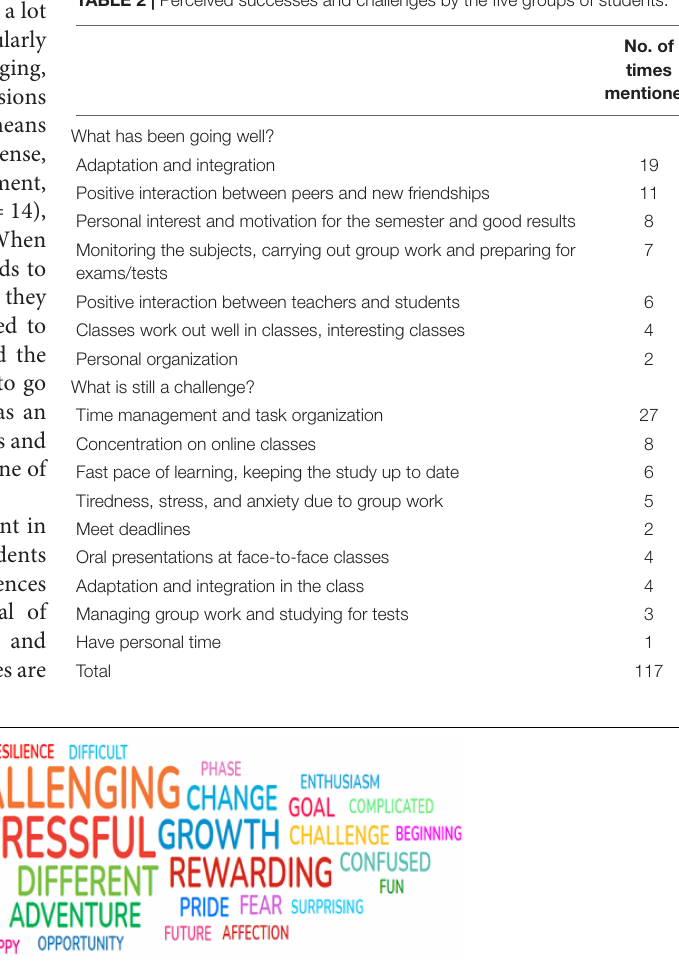
TABLE 2 | Perceived successes and challenges by the five groups of students.